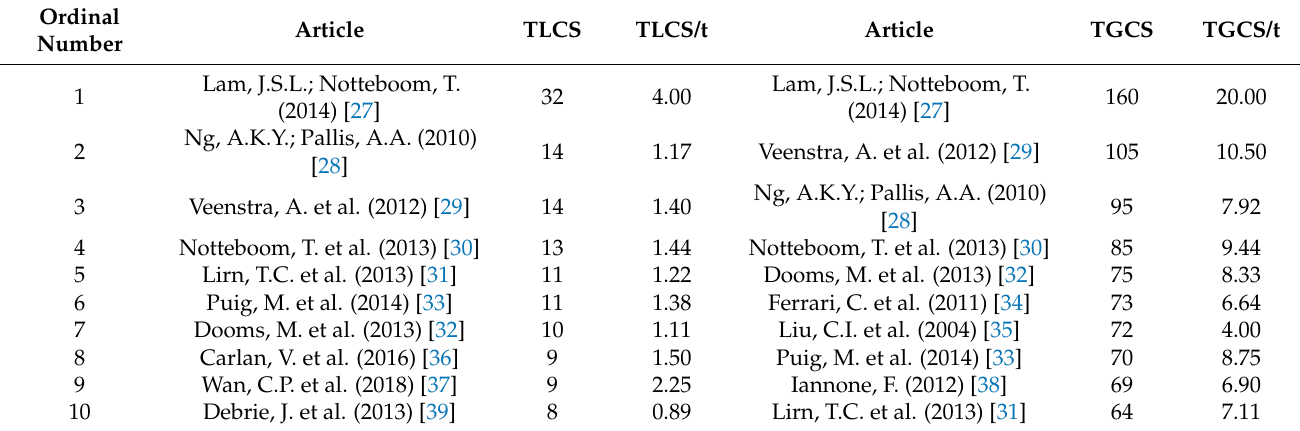
Table 4. The top 10 impactful scientific articles regarding the emerging green port research domain.